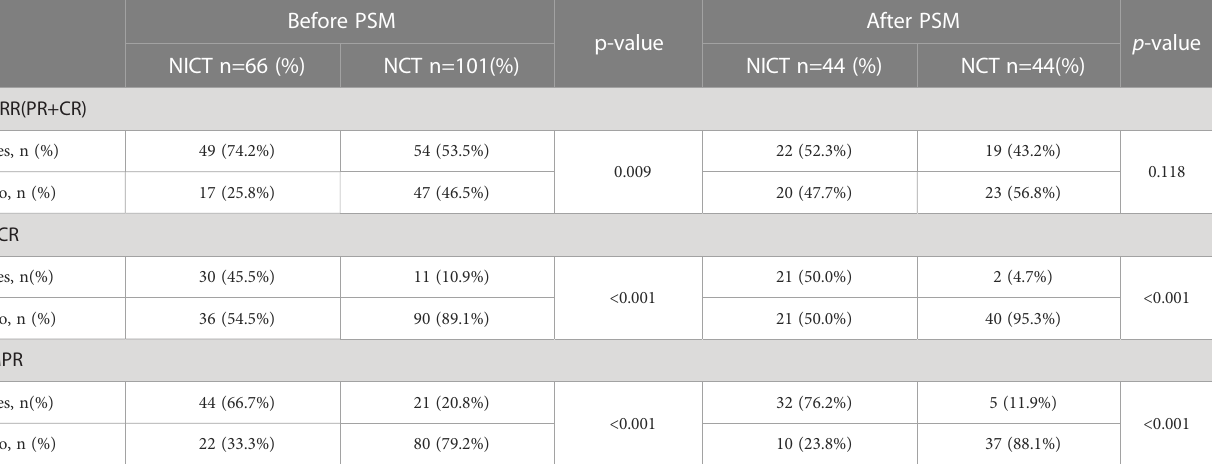
TABLE 5 Comparison of treatment effectiveness in NSCLC patients.